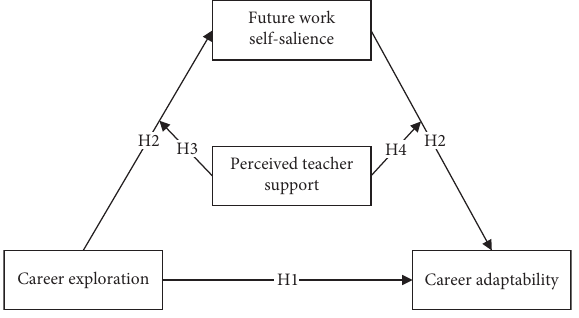
Figure 1: The relations among